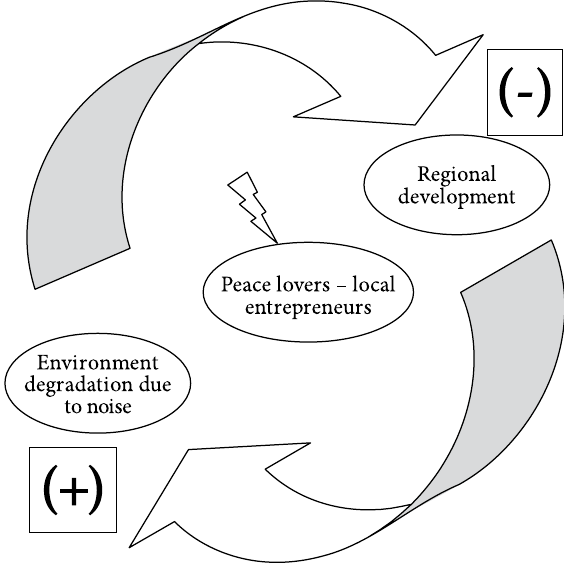
Fig. 1. A conflicting problem of regional development and environment